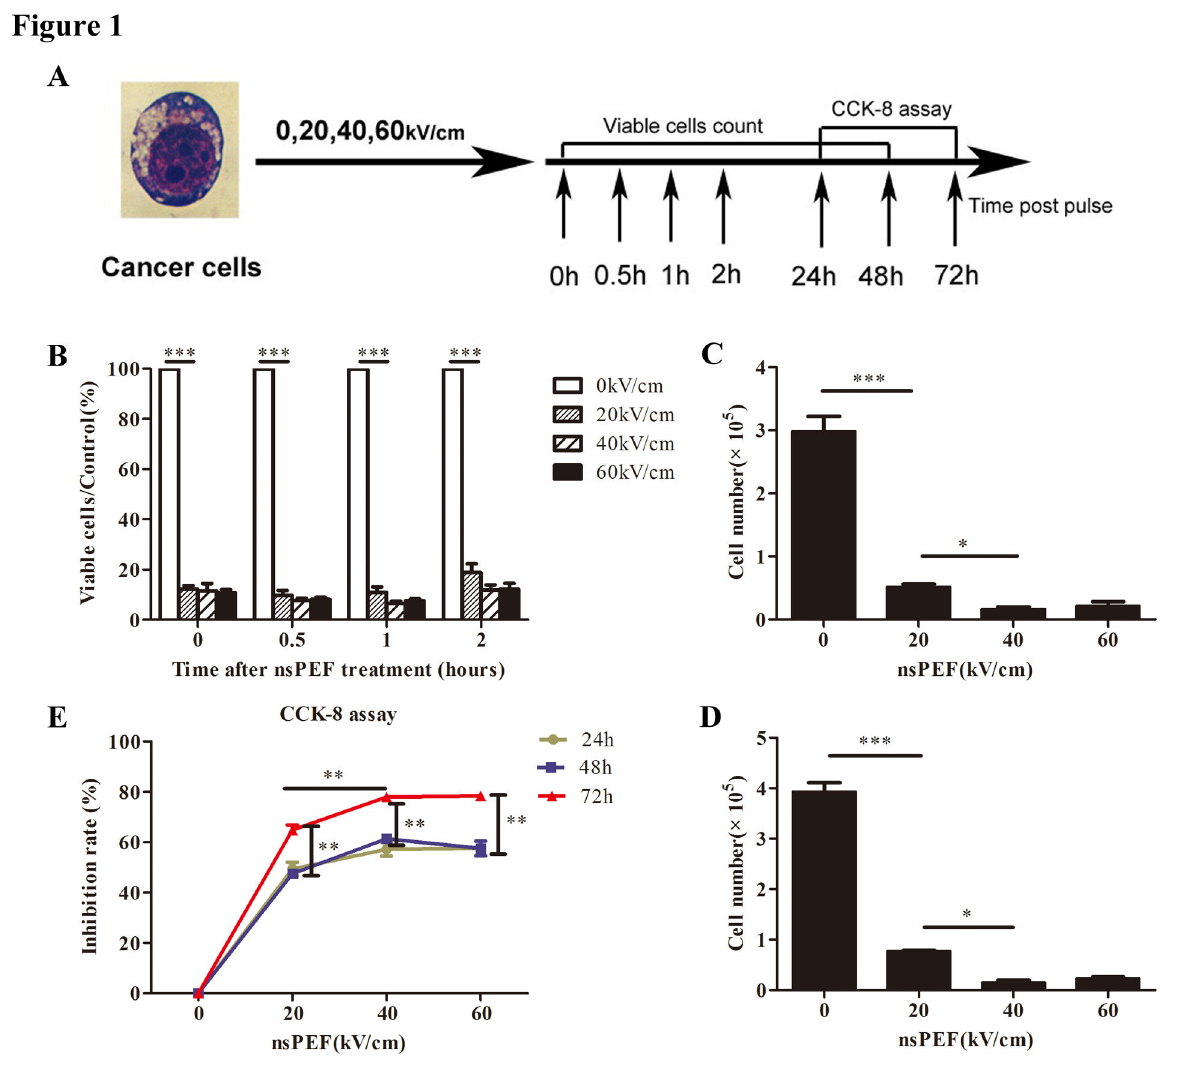
Figure 1. NsPEF induces cancer cells death and proliferative inhibition in vitro. (A) Schedule of cancer cells exposed to nsPEF with different intensities for viable cells count and CCK-8 assay. (B) The rate of viable cells/control was detected by counting trypan blue negative cells at 0 h, 0.5 h, 1 h, and 2 h post pulses with different intensities. ***p<0.001. (C and D) Numbers of viable cells were calculated after exposure to nsPEF with different intensities for 24 h and 48 h respectively. *p<0.05, ***p<0.001. (E) According to CCK-8 assay, inhibition rates of cells proliferation induced by nsPEF with different intensities were detected. **p<0.01. doi: